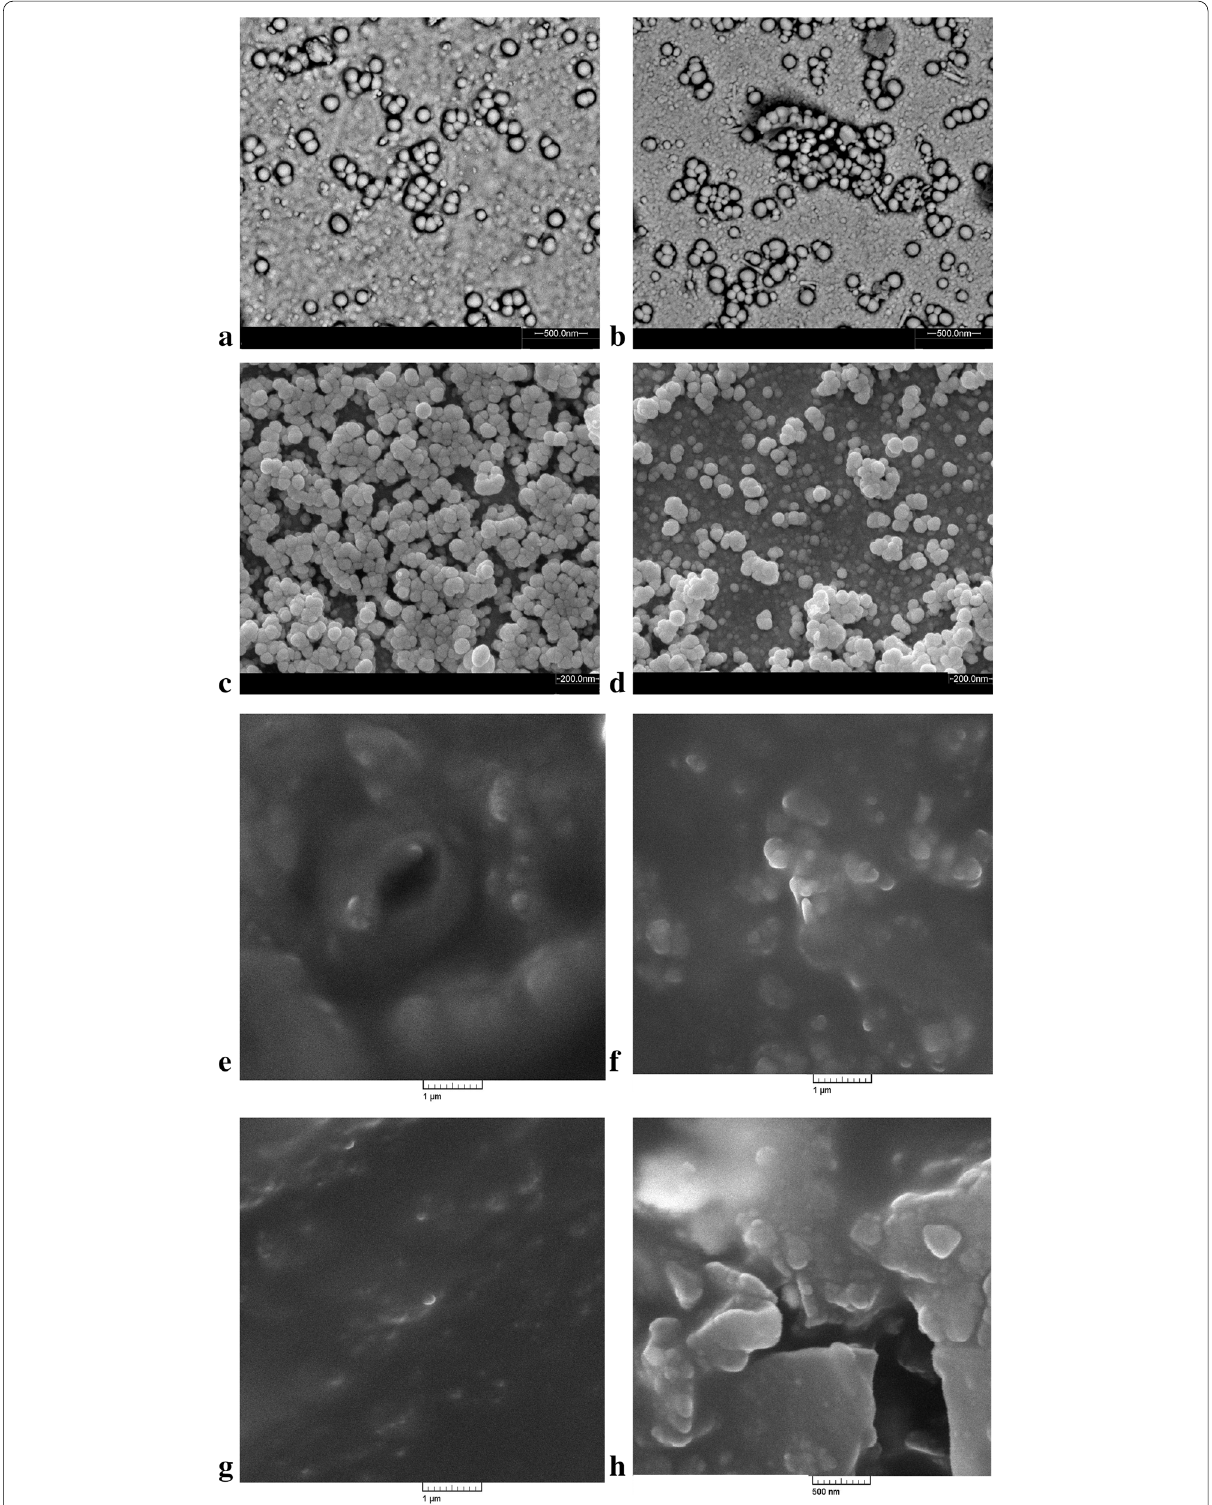
Fig. 6 SEM images of a NN in the optimum percentage, b FN in the optimum percentage, c NN after 30 days at 24 °C, d FN after 30 days at 24 °C, e NN after 90 days at 24 °C, f FN after 90 days at 24 °C, g NN after freeze-drying, and h FN after